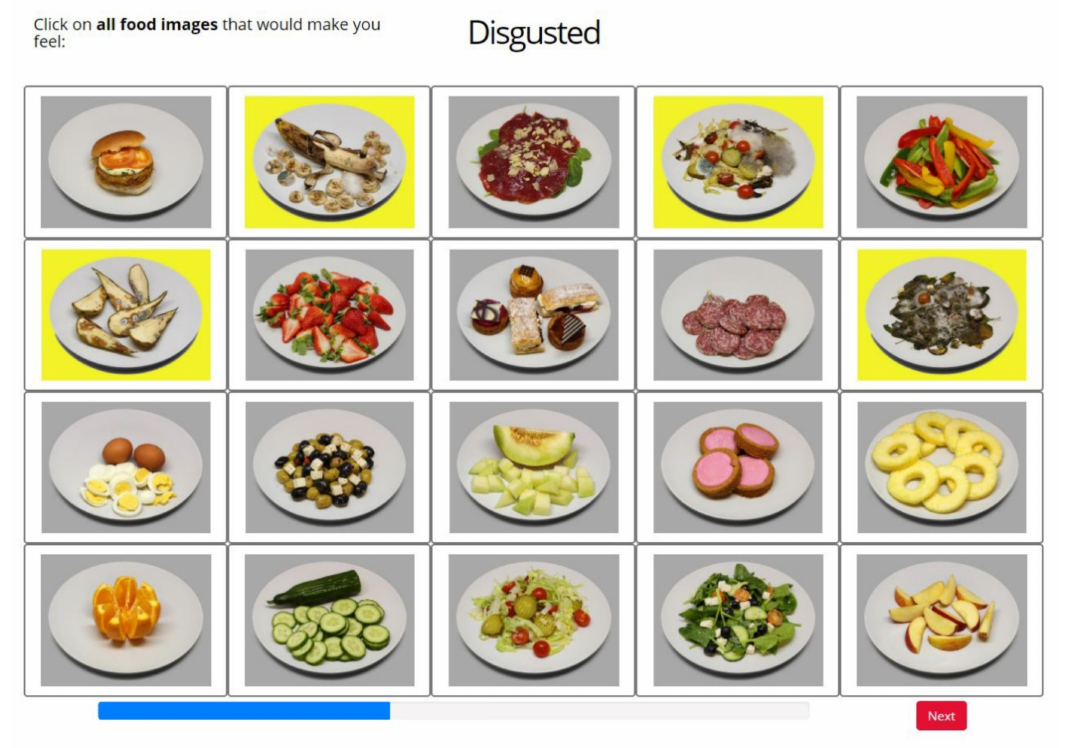
Figure 8. Screen layout of the Label2Image task: labeling food images with emotion terms (in this example the term “disgusted”). Images with a yellow background were selected by the participant. A blue progress bar indicated the progression of the task.